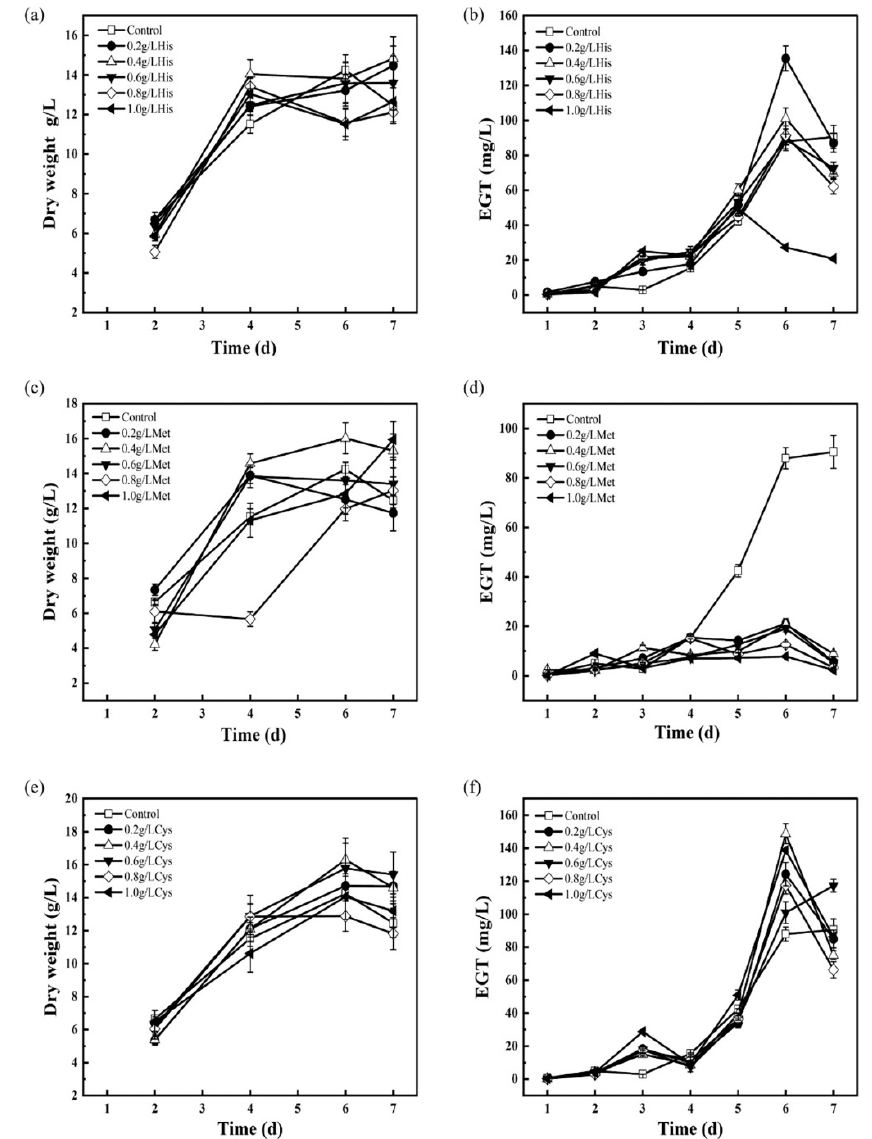
Figure 4. Effects of different concentrations of precursors on dry weight and ergothioneine production. ( a , c , e ) dry weight ( b , d , f ) ergothioneine production.